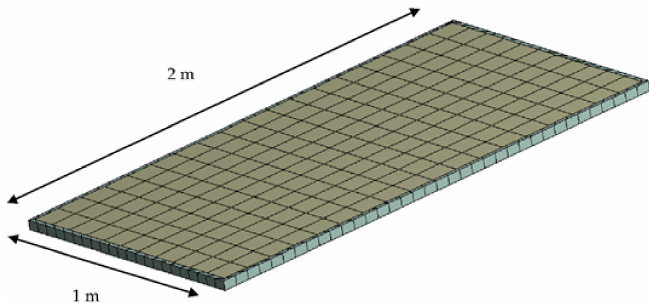
Figure 4. Mesh of the photovoltaic panel.